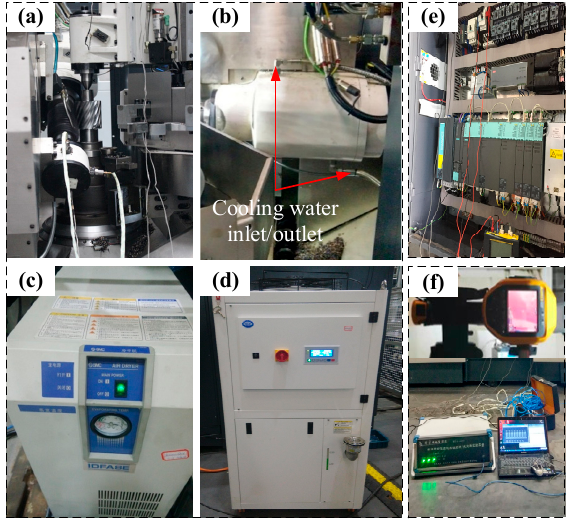
Figure 3. Experimental test for validation: ( a ) Gear hobbing; ( b ) Motorized spindle; ( c ) Refrigerated air dryer; ( d ) Water-cooling machine; ( e ) Power measurement; ( f ) Temperature test platform Table 1. Relevant parameters of the motorized spindle